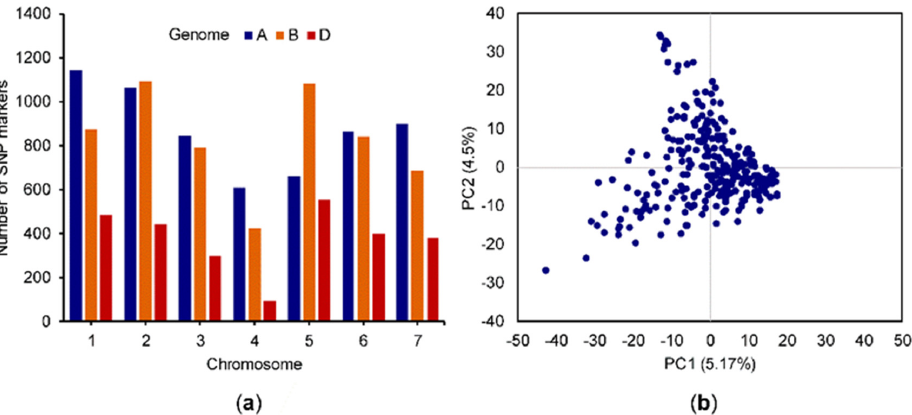
Figure 2. ( a ) Count of single-nucleotide polymorphisms (SNPs) on the wheat chromosomes (208 SNPs located on unanchored scaffold are not included in the plot); ( b ) principle component analysis of the 297 genotypes in the Hard Winter Wheat Association Mapping Panel (HWWAMP) using marker data.